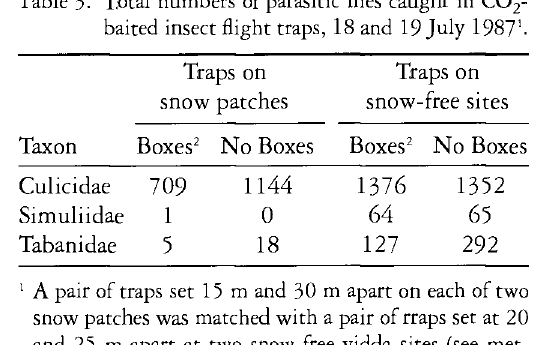
Table 5. Mean temperatures (°C) at four traps set